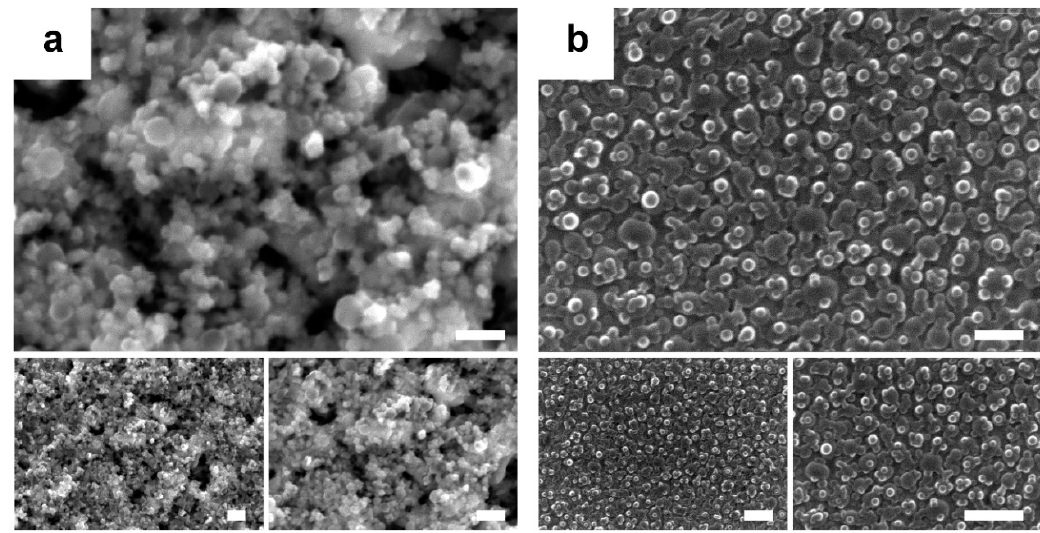
Figure 3. FE-SEM micrographs at different magnifications of the deposits obtained using PS- b -PEO (Bath 2) solution on ( a ) FTO-coated glass and ( b ) Si/Ti/Au substrates at − 1.3 V (vs. Ag|AgCl) after circulating 7.5 C cm − 2 . Scale bar: 300 nm.